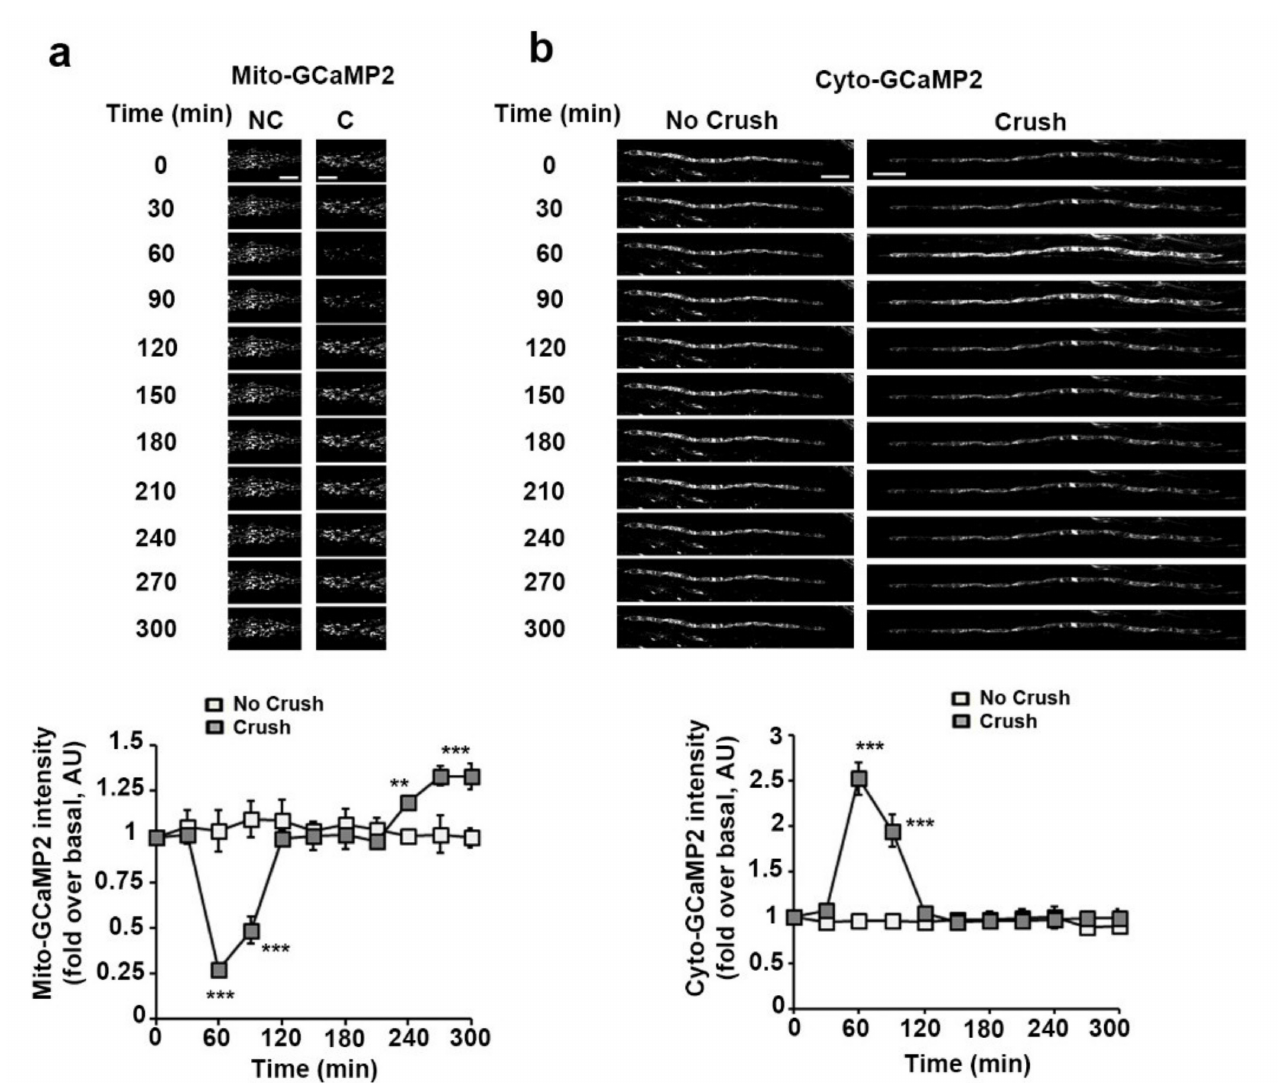
Figure 3. Mitochondrial and cytoplasmic calcium dynamics in SC following nerve injury. ( a ) Upper panels: Representative in vivo images of SC mitochondria labeled with adenovirus-delivered mito- GCaMP2 probe in non-crushed (No Crush) and crushed nerves (Crush) at successive time points. Scale bar= 5 µ m. Same magnification for all pictures. Lower panel: the average fluorescence intensity of the probe was measured for more than 100 mitochondria at the successive indicated time points in non-crushed (No Crush, n = 3 mice) and crushed nerves (Crush, n = 5 mice). The probe fluorescence intensity is normalized over the basal condition before crush. ( b ) Upper panels: Representative in vivo images of SC mitochondria labeled with adenovirus-delivered cyto-GCaMP2 probe in non- crushed (No Crush) and crushed nerves (Crush) at successive time points. Scale bar= 50 µ m. Same magnification for all pictures. Lower panel: the average fluorescence intensity of the probe was measured for more than 100 mitochondria at the successive indicated time points in non-crushed (No Crush, n = 3 mice) and crushed nerves (Crush, n = 4 mice). The probe fluorescence intensity is normalized over the basal condition before crush. Error bars indicate SEM. Statistical tests are two-way ANOVA Sidak post hoc test comparing non-crushed to crushed nerves values. All mice were 8 to 11 weeks old. ** p < 0.01, *** p <